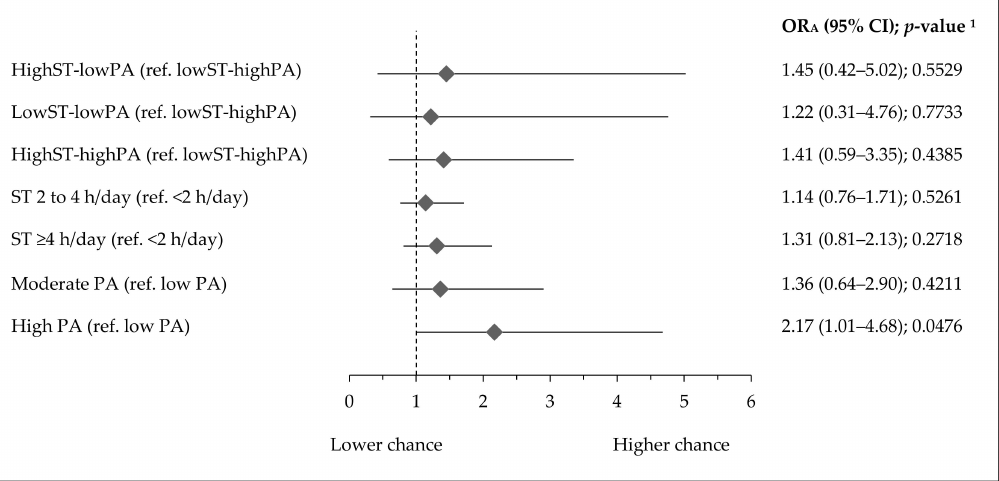
Figure 4. Association of activity–inactivity patterns, ST, and PA with higher muscle strength in Polish teenagers (ref. normal muscle strength). Notes: ST—screen time; PA—physical activity; higher and normal muscle strength identified as z-score handgrip strength as follows: higher > 1 SD, normal—1 to 1 SD; OR A —odds ratio adjusted for gender, age (years), residence (categorical variable), Family A ffl uence Scale (points) and Nutrition Knowledge Score (points); 95% CI—confidence interval; 1 Wald test significance